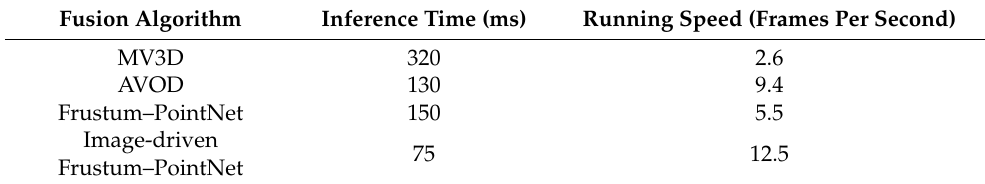
Table 8. Speed comparison of different fusion algorithms.